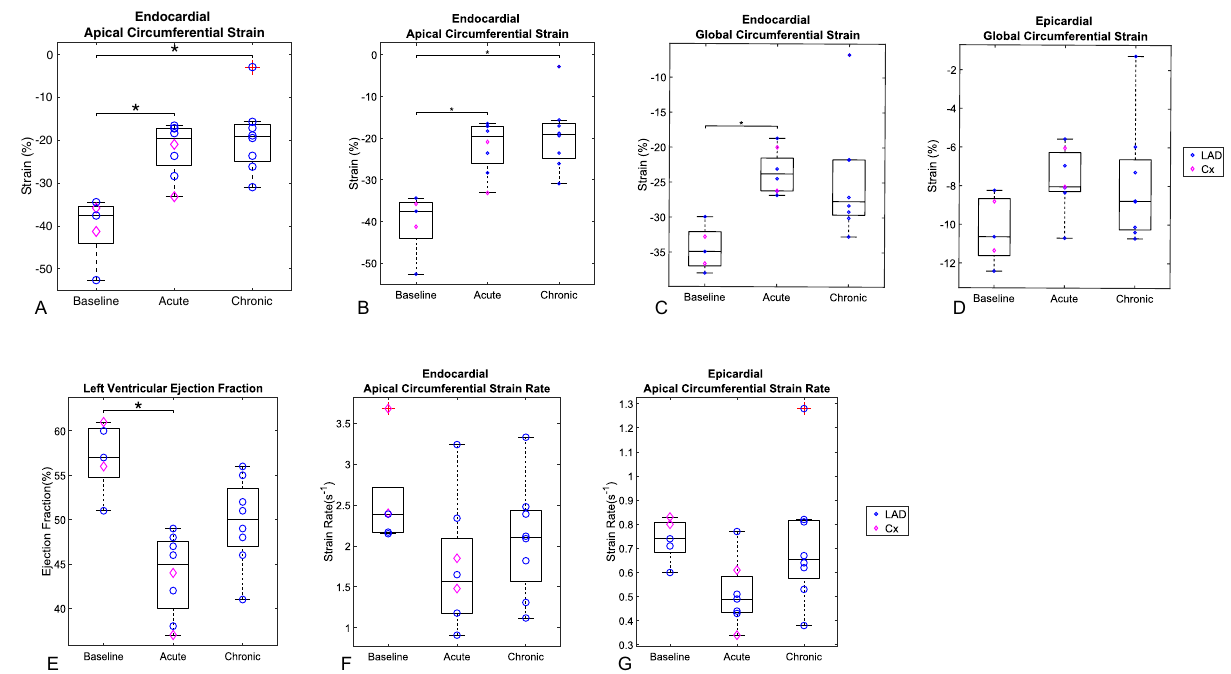
Figure 3. ( A - D ) Overtime changes in apical and global circumferential strains. ( A ) Endocardial apical circumferential strain (ACS); ( B ) Epicardial apical circumferential strain (ACS); ( C ) Endocardial